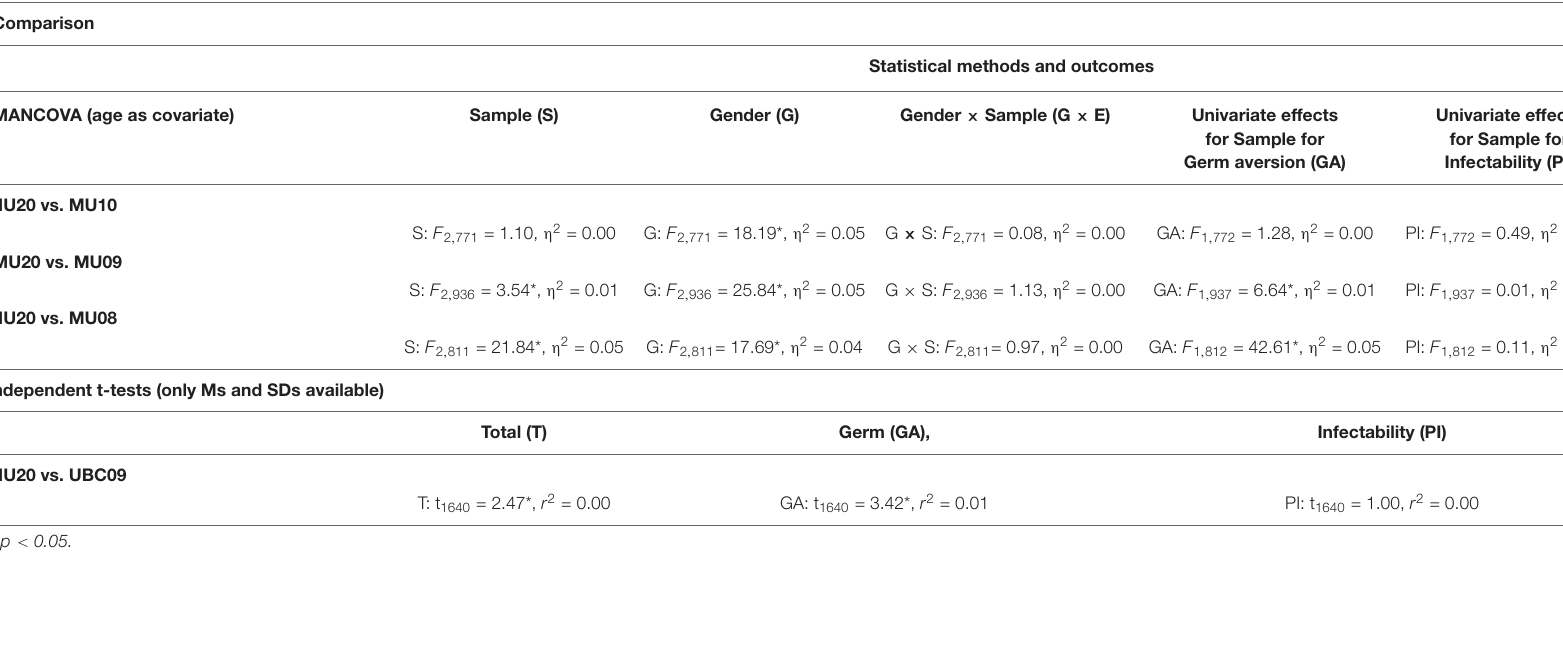
TABLE 7 | Comparison of the current sample with previous student samples for the Perceived Vulnerability to Disease Questionnaire. Comparison MANCOVA (age as covariate)